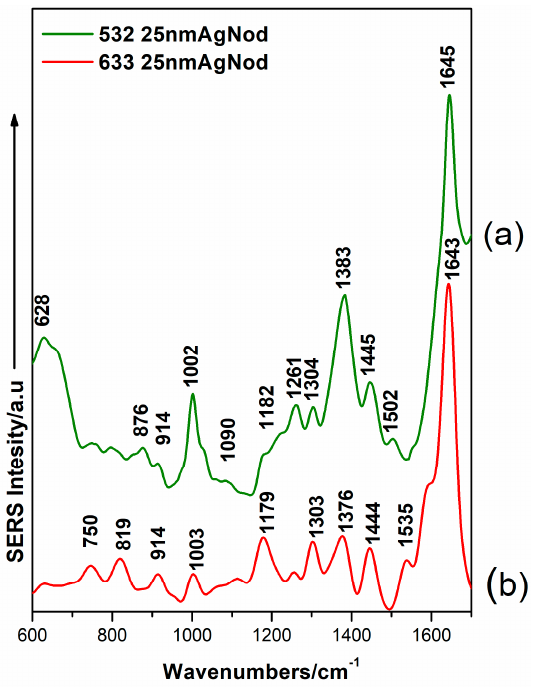
Figure 6. SERS spectra on of NOD/ethanol samples at 10 − 3 M concentration using the 532 nm laser line ( a ) and 633 nm laser line ( b ) using 25 nm Ag covered nanotrenches on plastic.